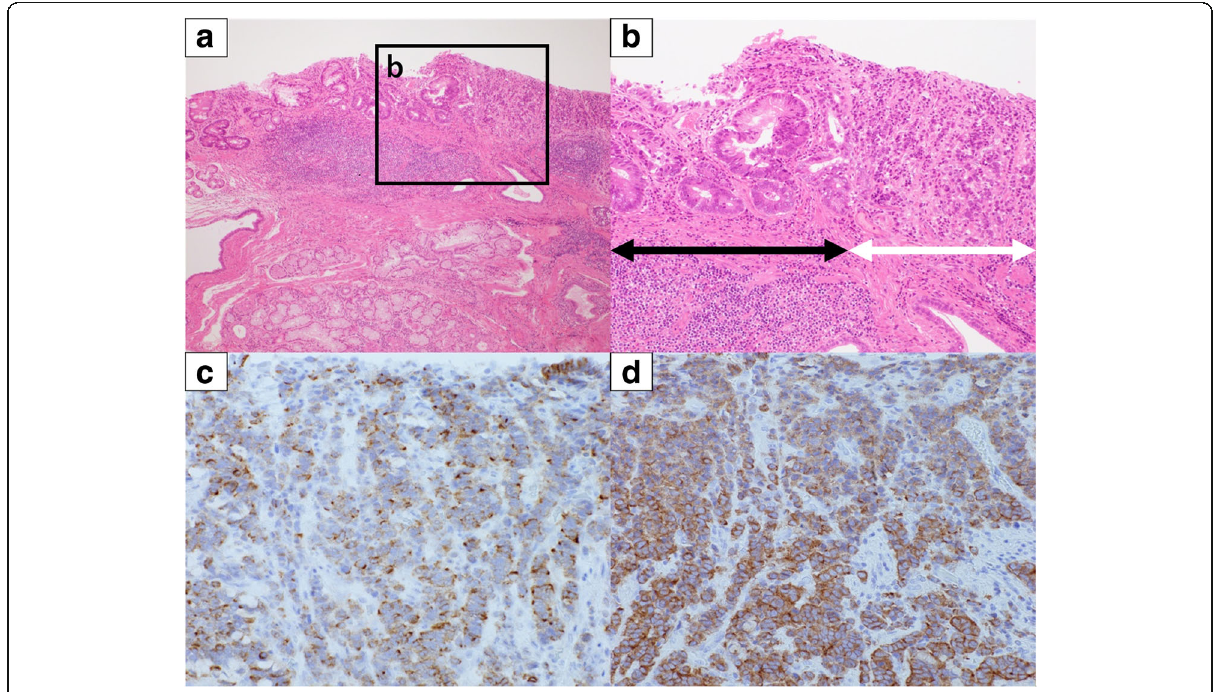
Fig. 3 Histopathological findings. a Hematoxylin-eosin staining shows that the tumor arose in Barrett ’ s epithelium (× 40). b Magnification of the part indicated by the square in ( a ) (×100). The tumor shows two components ( black and white arrows ). The black arrow indicates a well-differentiated adenocarcinoma, whereas the white arrow indicates a neuroendocrine carcinoma. c Immunohistochemical staining for chromogranin A is positive (× 200). d Immunohistochemical staining for synaptophysin is positive (×